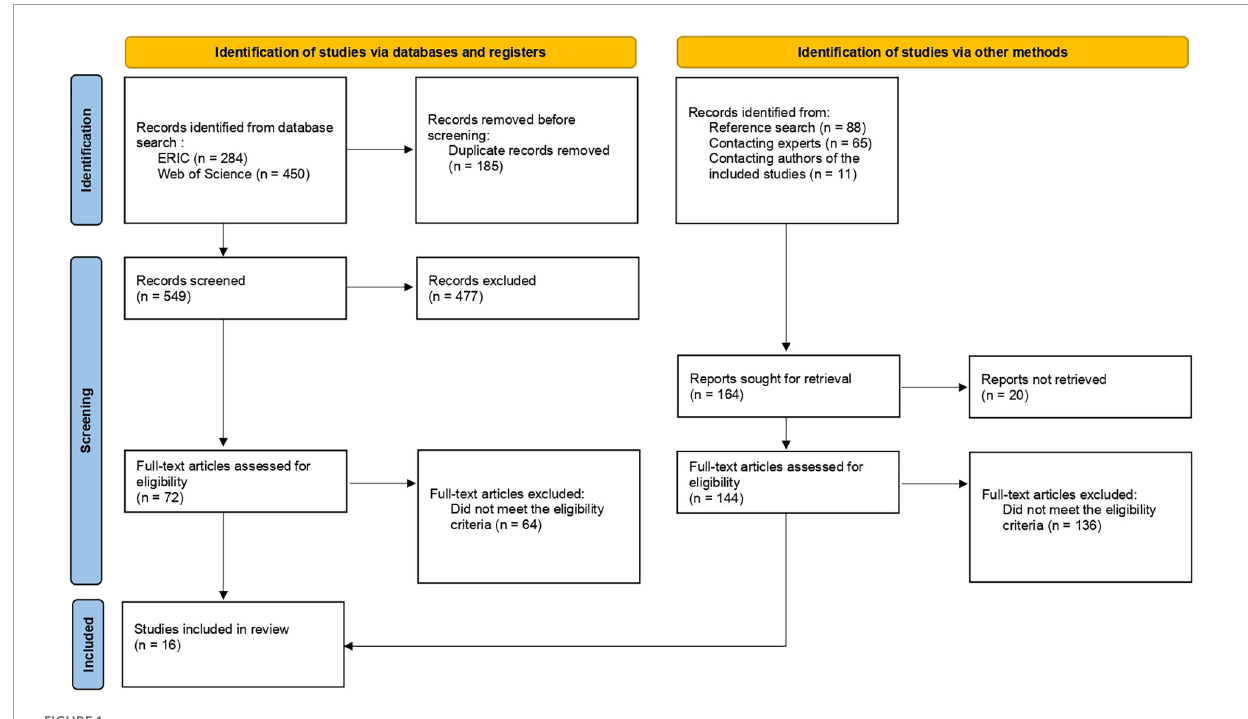
FIGURE1 PRISMA flow diagram (updated from Page et al.,